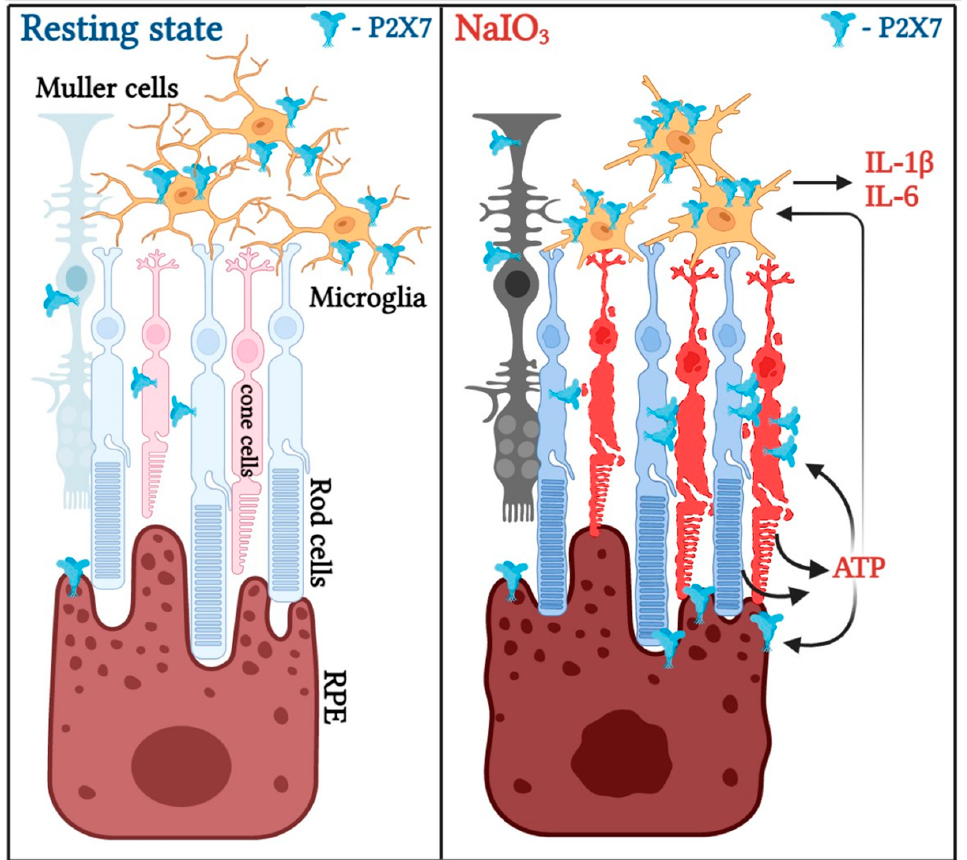
Figure 9. Schematic representation of P2X7 activation in amplification of NaIO 3 -induced neuroin- flammation and retinal cell death. ( Left ) In normal conditions, P2X7 is constitutively and highly expressed in microglia than photoreceptors, RPE and Müller cells. ( Right ) Upon NaIO 3 treatment, P2X7 expression in photoreceptors, Müller cells and RPE cells is increased, and cell death in these cell types, as well as microglia, is evoked. ATP releasing from the dying and damaged cells acts as a DAMP to activate microglia for inflammatory IL-1 β and IL-6 gene expression. High concentration of ATP might also promote RPE cell death under NaIO 3 stress.